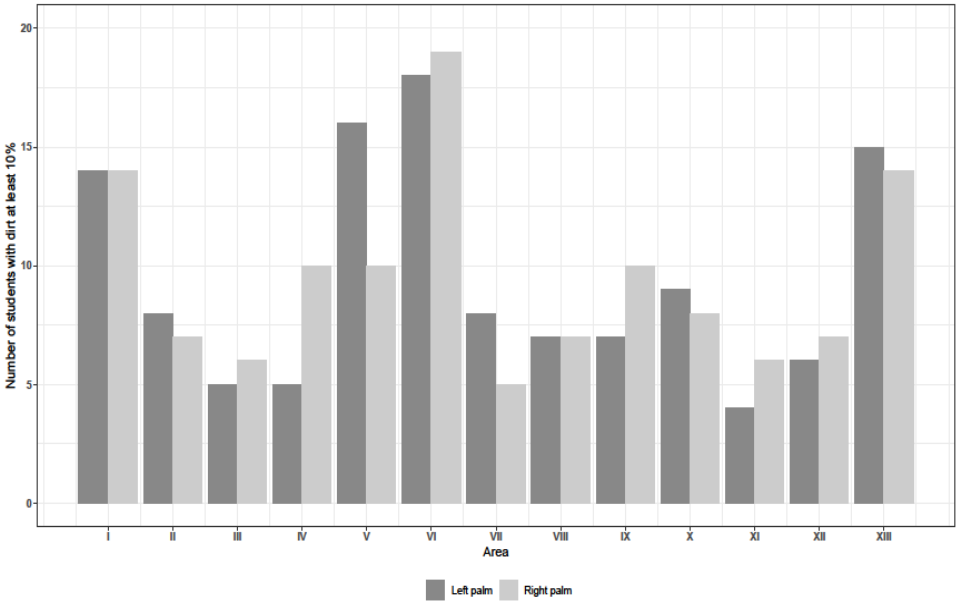
Figure 2. Improperly disinfected palms (dirt ≥10%).